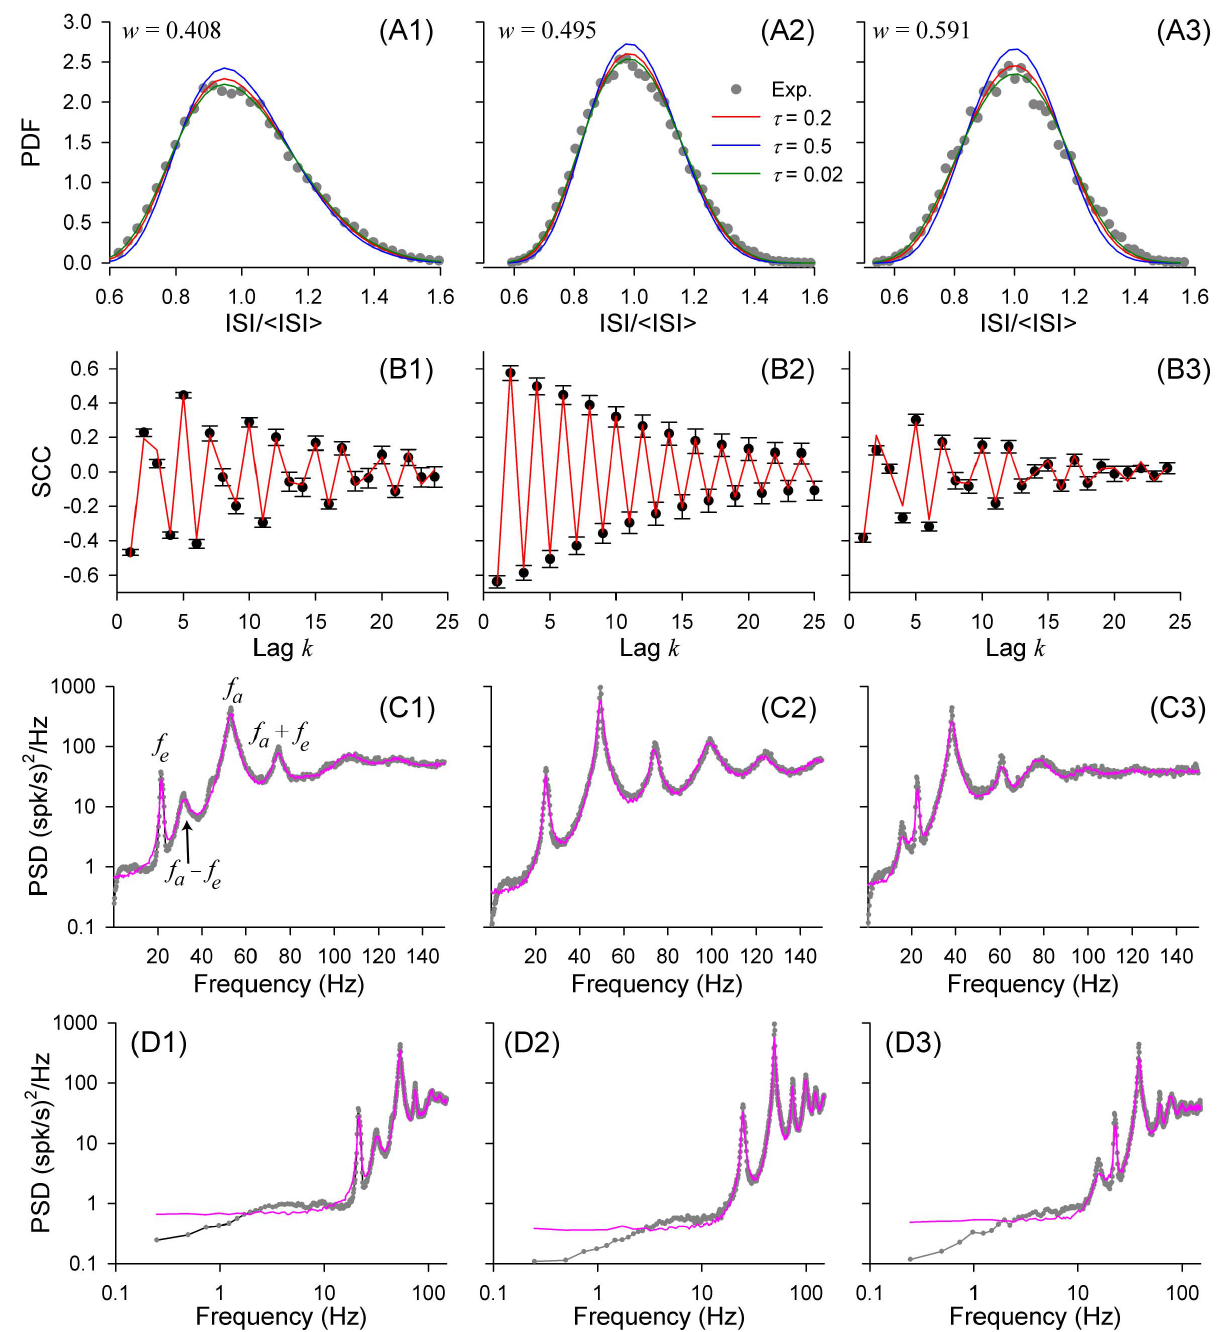
Figure 7. Experimental data from three representative paddlefish electroreceptor afferents (dots in A1–A3, dots and error bars in B1–B3, and gray lines in C1–C3), compared to theory, for the values of the frequency ratio, w , listed at the top. A : ISI probability density functions (PDFs). Theoretical PDFs (red, blue, green lines) were calculated using Eq.(6) with n ~ 1 ; ^ tt ~ 0 : 02 , 0.2 and 0.5 (legend in A2), and other parameters derived from fitting the SCCs, as explained in the Methods, final section. B : Serial correlation coefficients (SCCs). Theoretical red lines show least square fits using Eq.(12). C–D : Power spectral densities (PSDs). Theoretical lines (magenta) were obtained from numerical simulation of the PIF model using Eqs.(1–4), with ^ tt ~ 0 : 2 , and other parameters the same as for theoretical curves in panels A1–3, derived from the SCC fitting